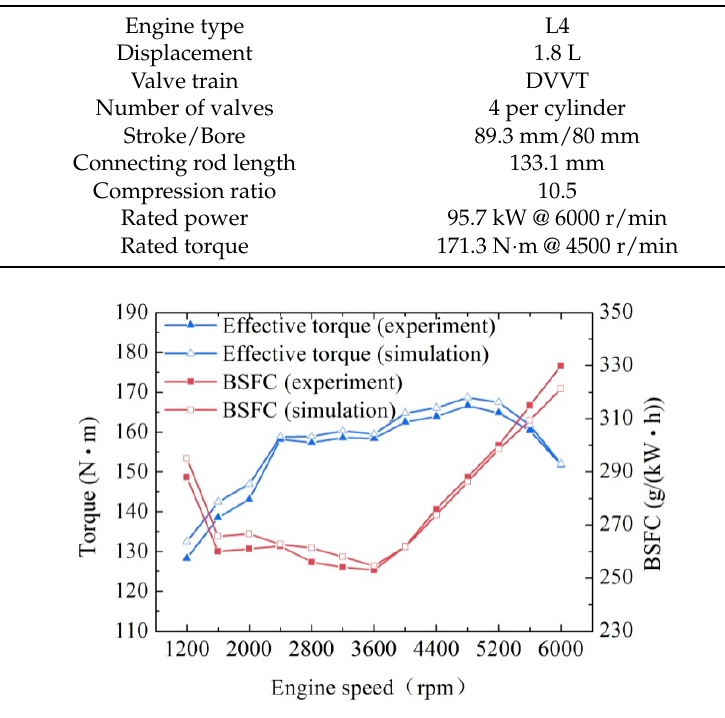
Figure 7. Comparisons of simulations and experiments under full load condition.